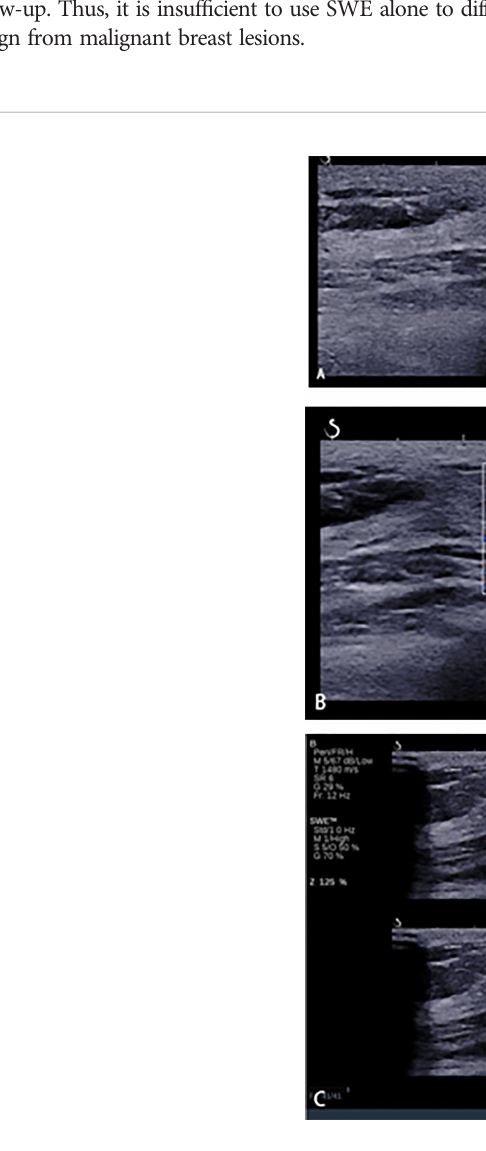
FIGURE 5 | A 45-year-old woman with breast lesions. (A) Conventional B-mode ultrasound revealed a 10 × 6-mm round, hypoechoic lesion with a clear margin in the right breast, which was categorized as Breast Imaging Reporting and Data System (BI-RADS) 4a. (B) The morphologic and distribution features of the microvessels in AngioPLUS microvascular Doppler ultrasound technique (AP) followed a linear pattern. (C) The qualitative shear wave elastography (SWE) feature showed no fi nding. Considering the benign manifestation both in AP and qualitative SWE, the fi nal category was downgraded into BI-RADS 3. The ultrasound- guided biopsy revealed the lesion as fi